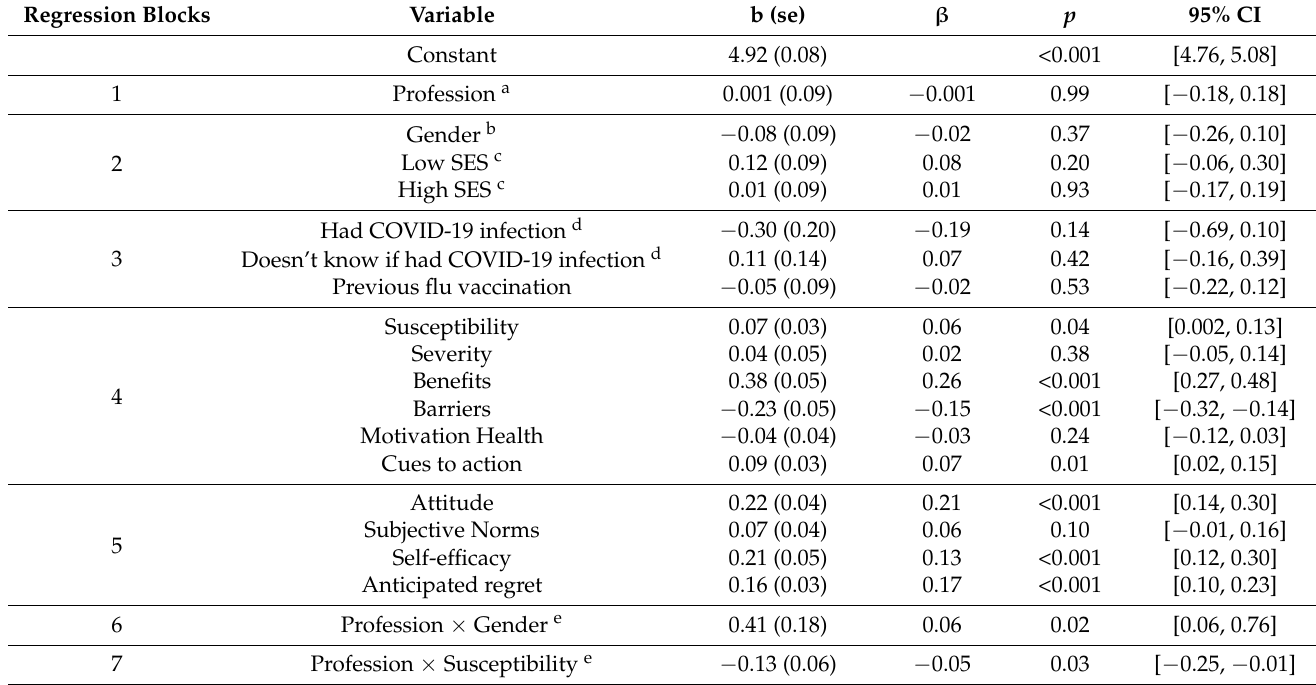
Table 3. Coefficients of the final (seventh) step of the hierarchical